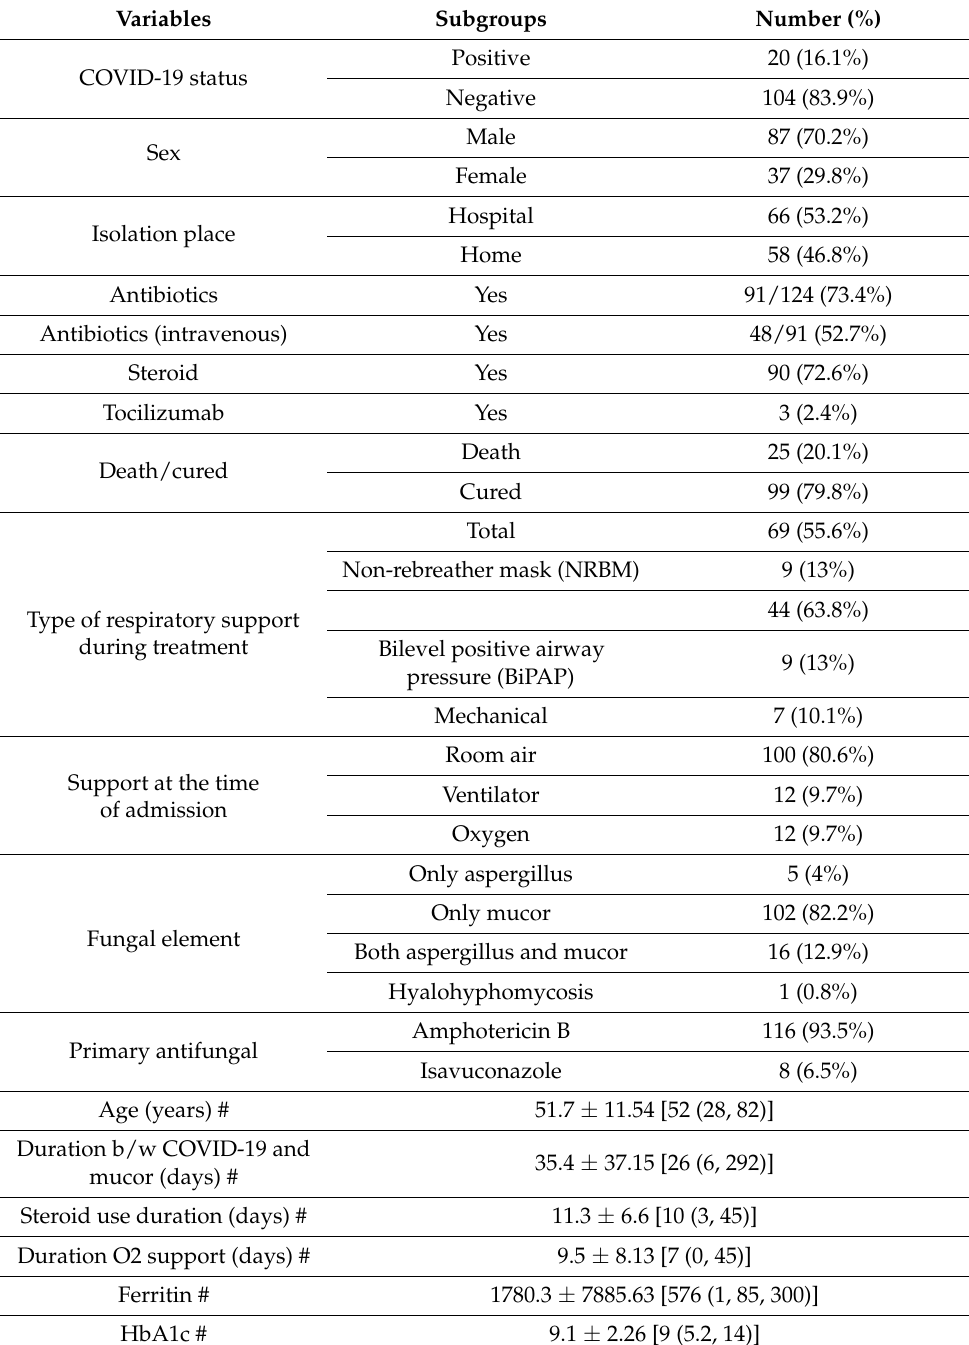
Table 1. Distribution of the demographic, treatment, inflammatory markers, respiratory support, and outcomes of COVID-19 patients (N =